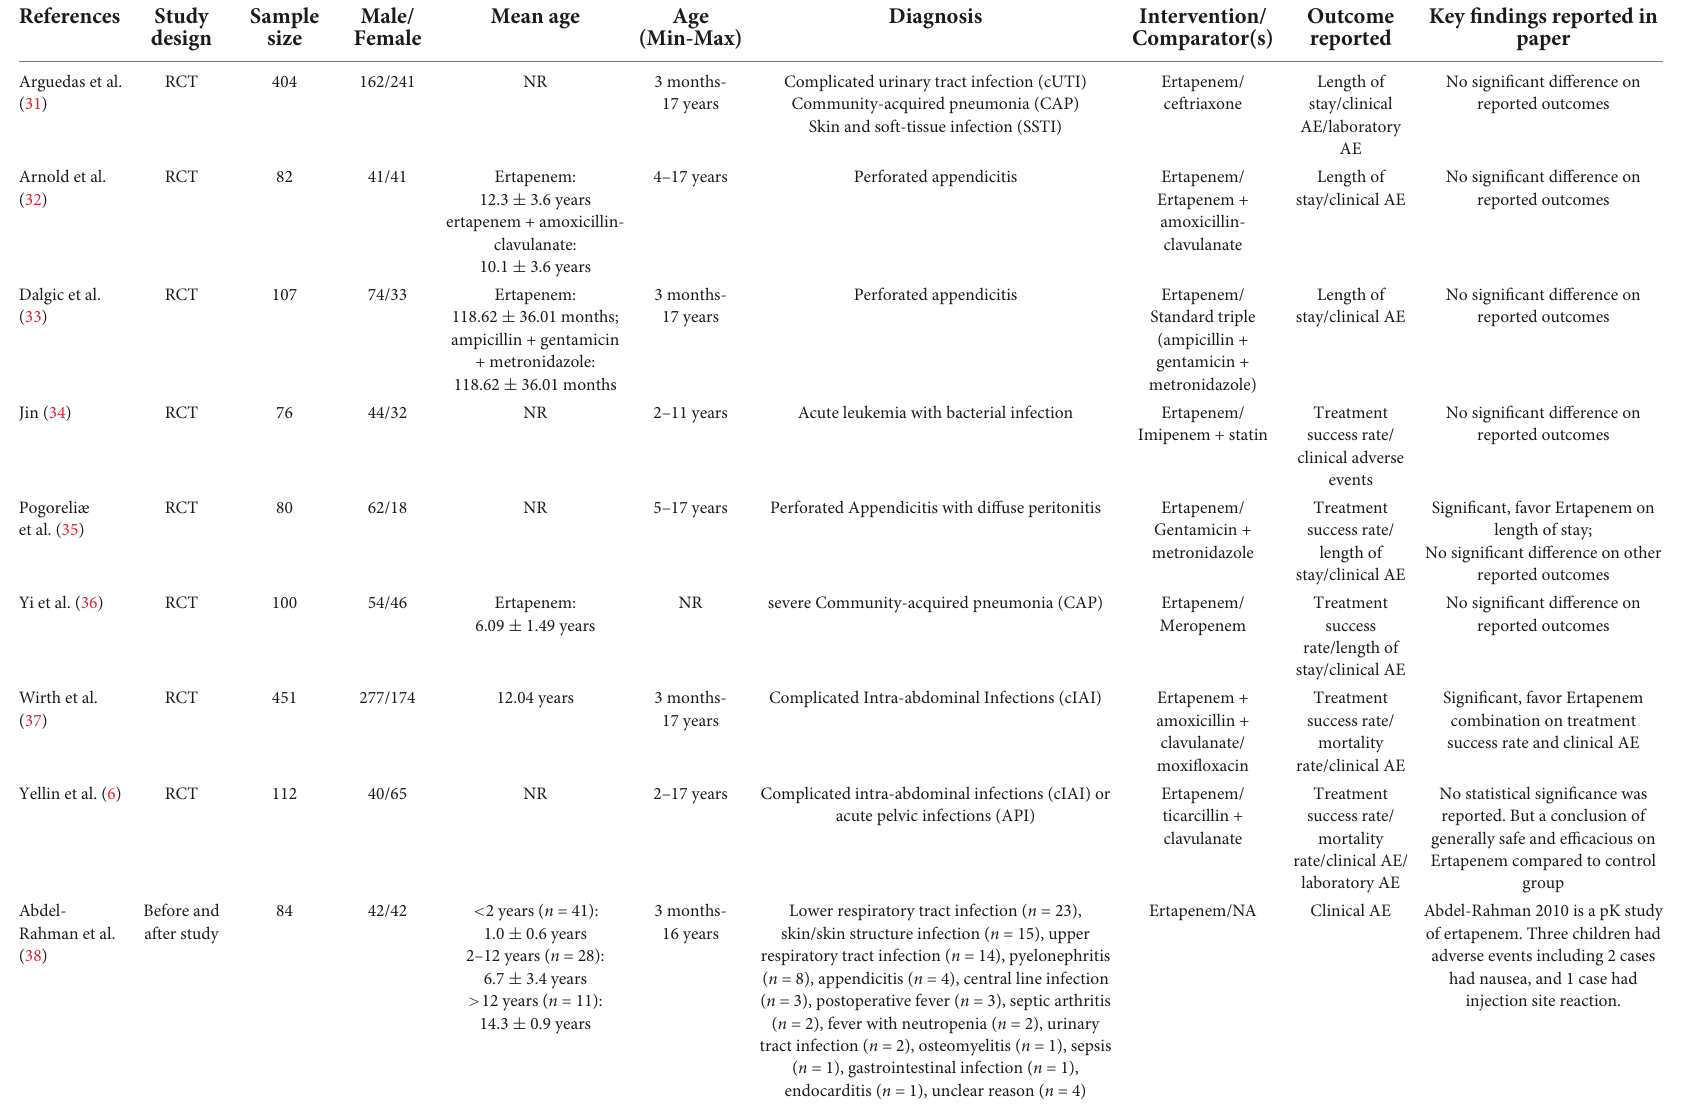
TABLE 1 Characteristics of included